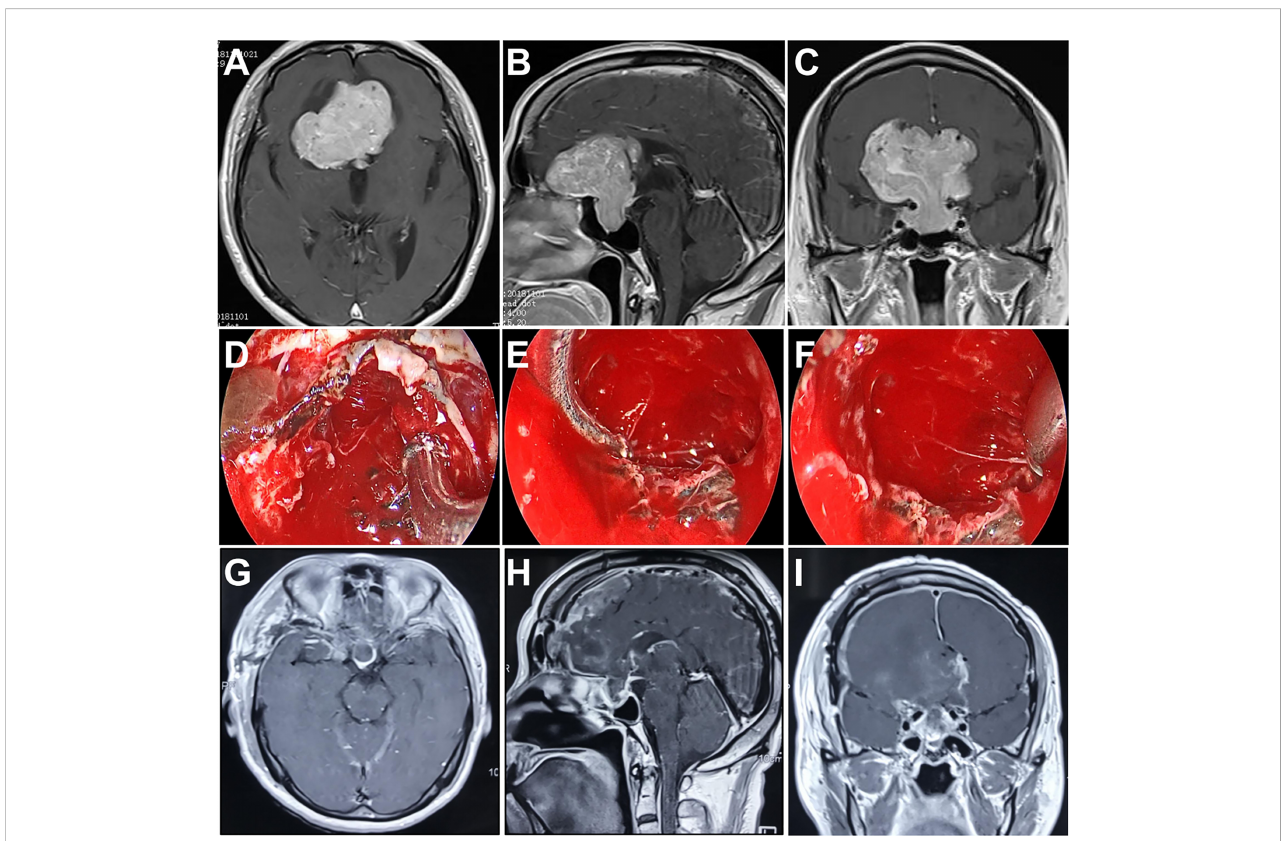
FIGURE 3 Case 2. Pre- and postoperative imaging fi ndings and intraoperative images. (A – C) Preoperative axial (A) , sagittal (B) and coronal (C) gadolinium- enhanced T1-weighted MRI images showing a giant pituitary adenoma with extensive suprasellar extension. (D) Intraoperative photograph showing that the diaphragma sellae is sharply opened and the intrasellar tumor is removed with angled suctions under endoscopic view. (E, F) Intraoperative endoscopic photographs showing the fi nal view of the medial walls of both sides of cavernous sinus as well as the anterior wall of sella turcica after removal of the tumor. (G – I) Postoperative axial (G) , sagittal (H) and coronal (I) gadolinium-enhanced T1-weighted MRI images showing gross total resection of the pituitary